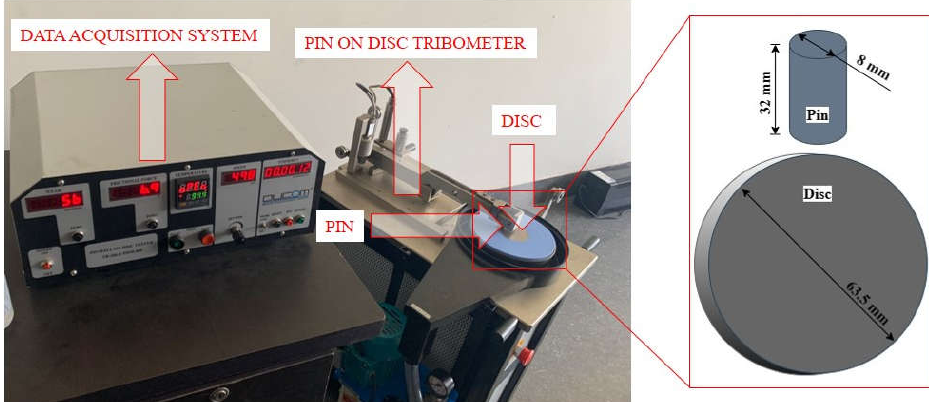
Figure 1. The experimental setup for tribological investigation.